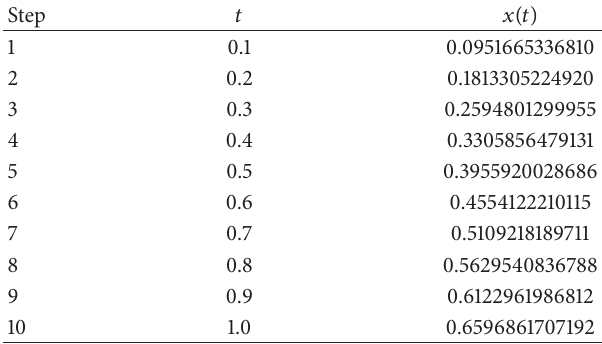
Table 1: Numerical evolution of the symbolic approximation 𝑥 𝑆 (𝑡) , for 𝑚 = 1000 .